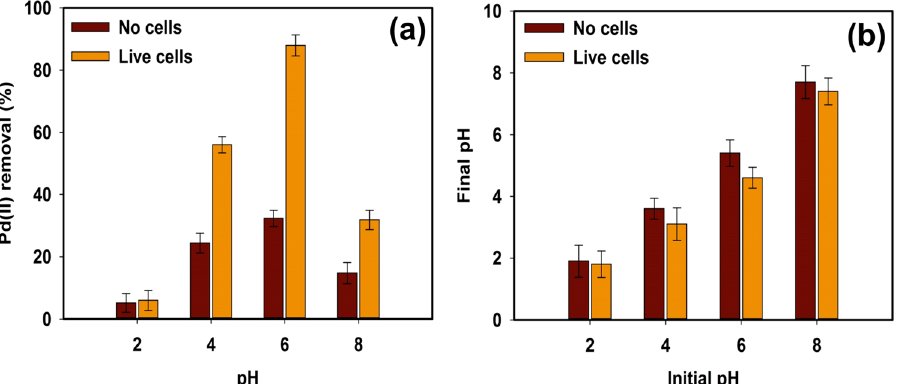
Figure 1. The effect of initial pH on ( a ) Pd(II) removal from the aqueous phase and ( b ) final pH using no microbial cells and live microbial